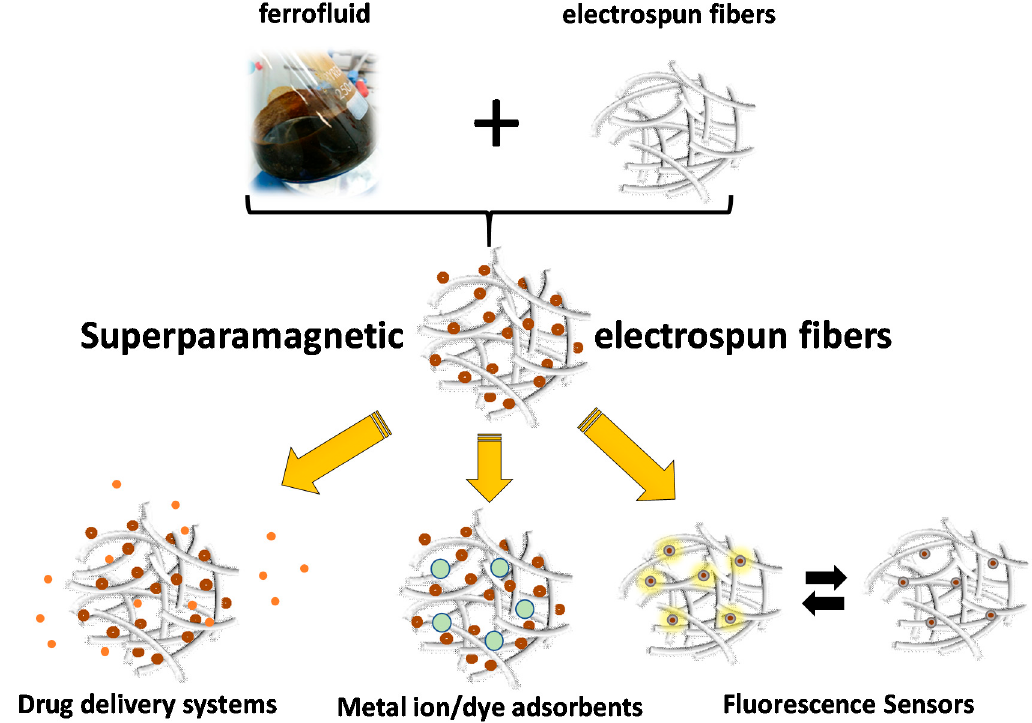
Figure 12. Superparamagnetic electrospun fibers generated from ferrofluids and electrospun nano ‐ and